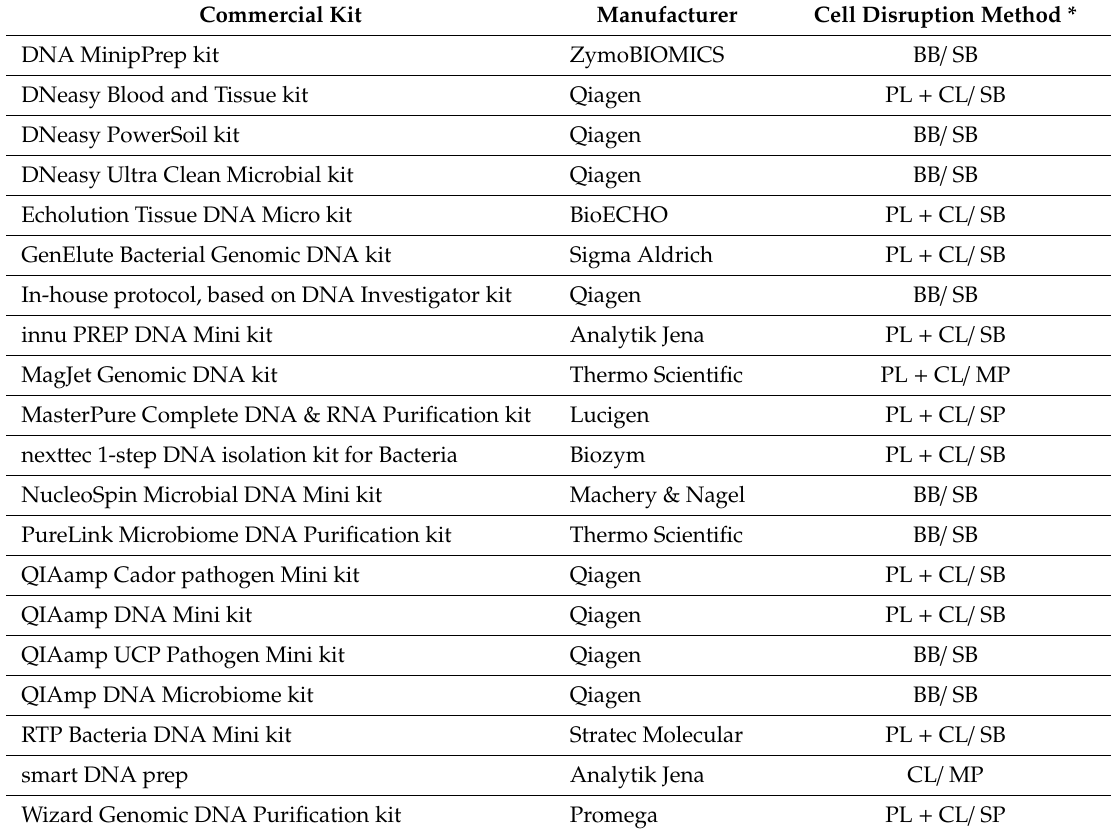
Table 1. Commercial DNA extraction and purification kits used in this